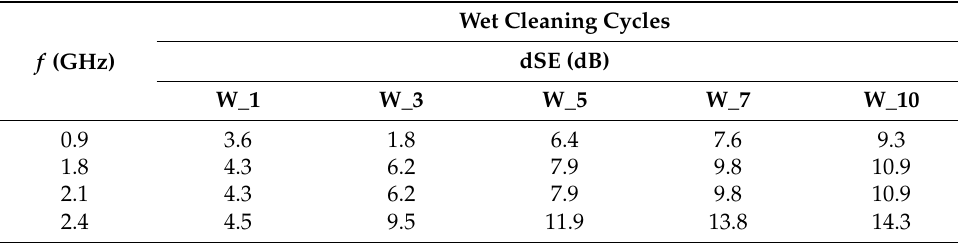
Table 4. Difference in the shielding effectiveness of the PA/Ag fabric after the impact of wet cleaning